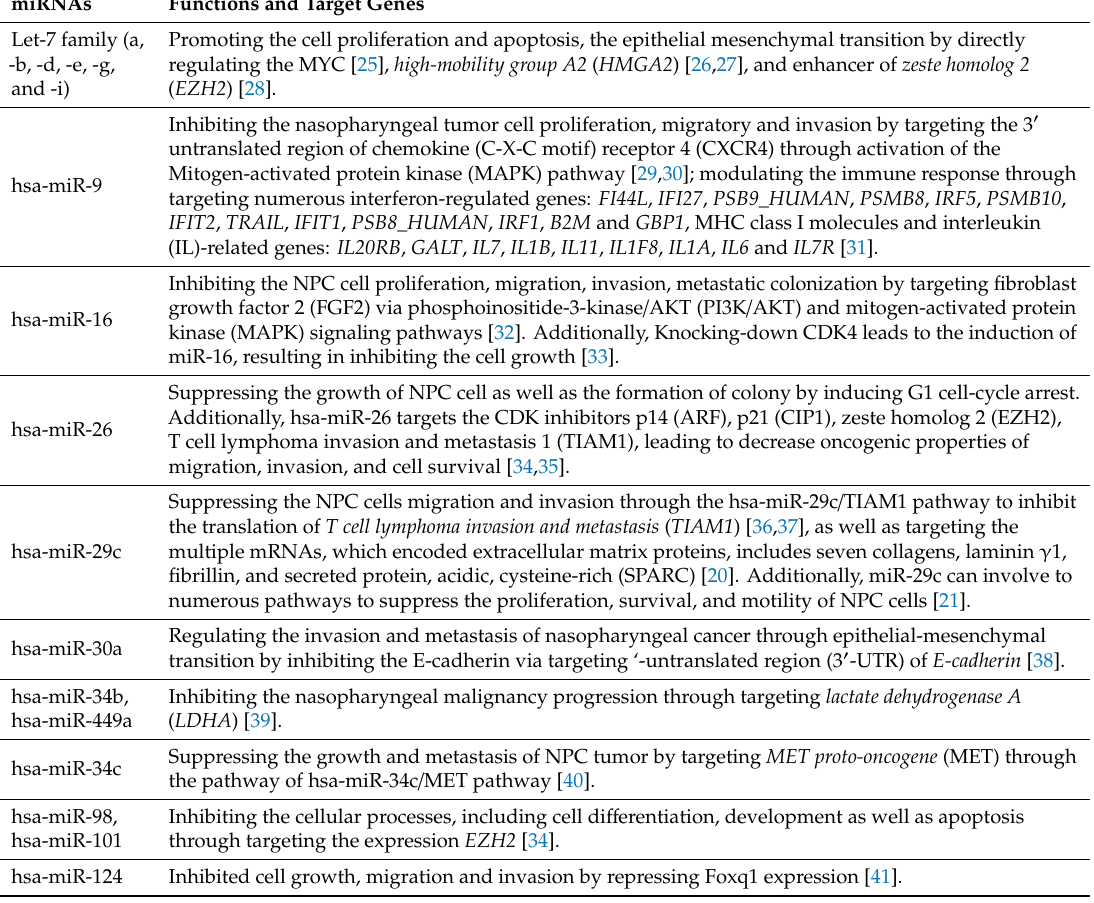
Table 1. List of miRNAs that act as tumor suppressor genes in nasopharyngeal carcinoma (NPC). miRNAs Functions and Target